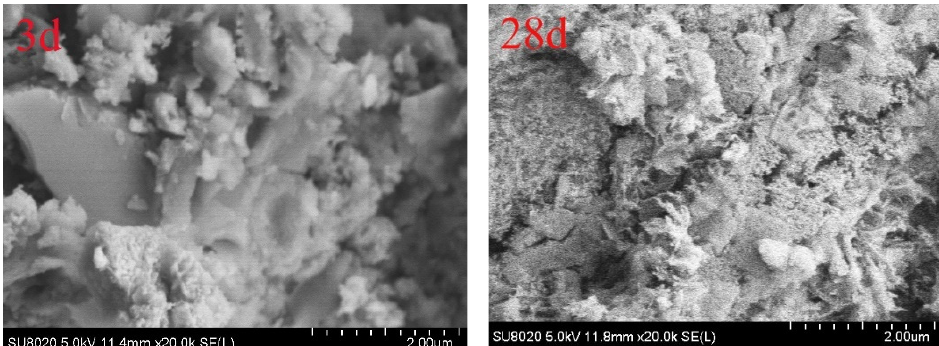
Figure 11. Results of the PM2 sample SEM of different ages.